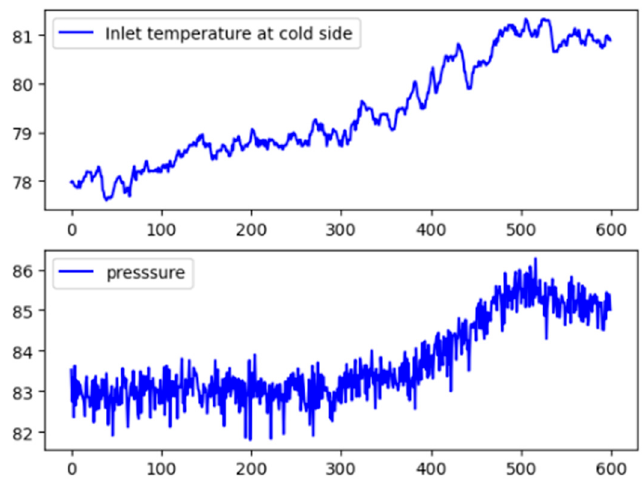
Figure 19. Original data in case two.